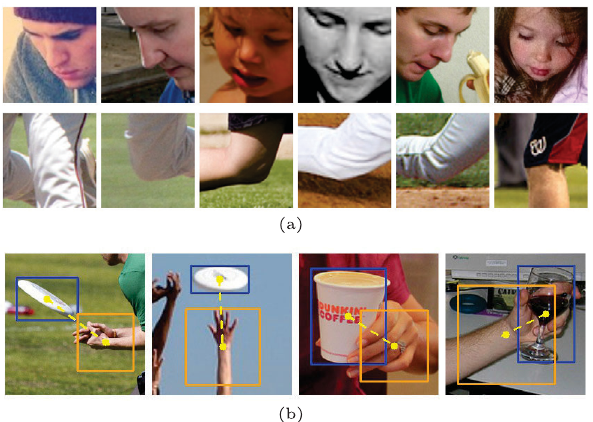
Fig. 3 Examples of part-level pairwise features. (a) Body part regions, e.g., head state (above) for read and knee state (below) for throw . (b) We augment the object feature by cropping the feature from the expanded union box covering the object (blue) and its neighbouring body part (e.g., hand) to enrich the visual cues for local interactions, e.g., throw and hold , which are strongly correlated with body parts. The distance between the object and body part (dashed lines) is utilized as a local spatial